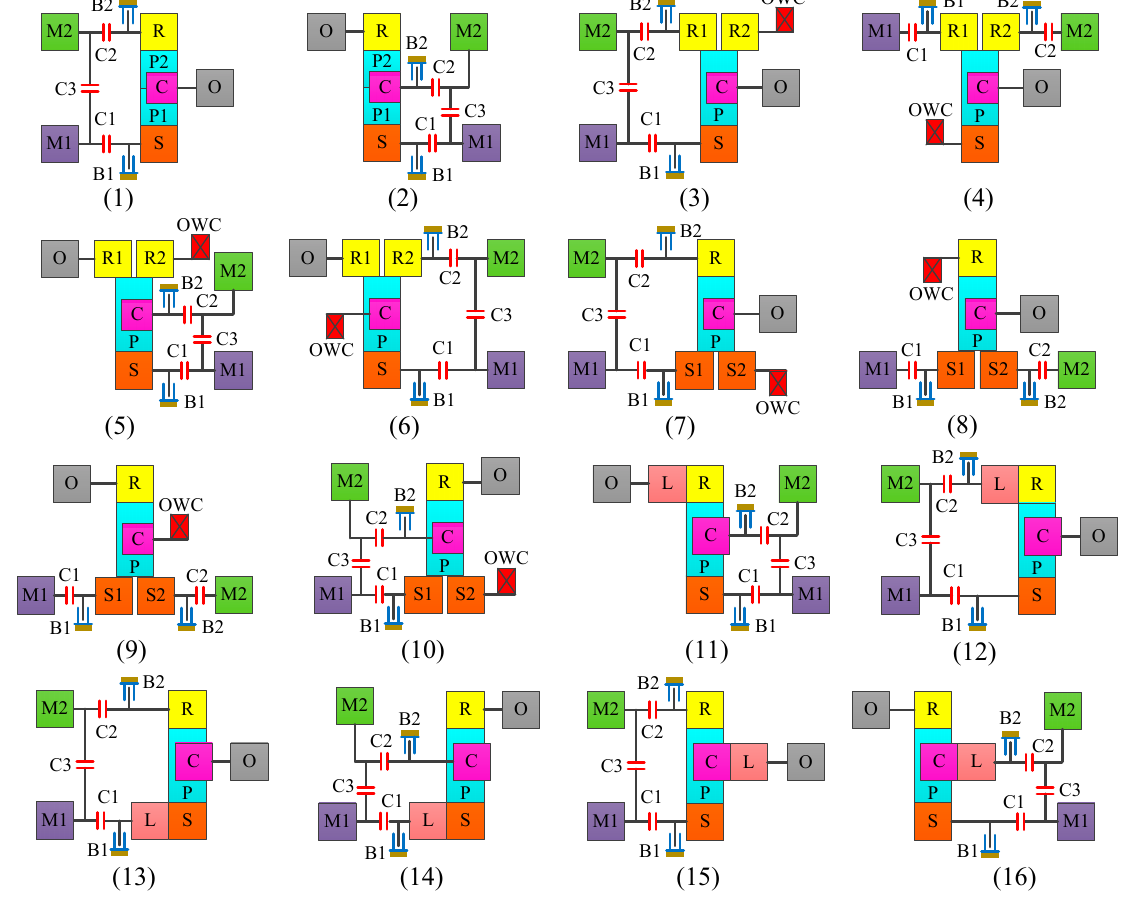
Figure 10. Atlas of the novel motor transmissions.